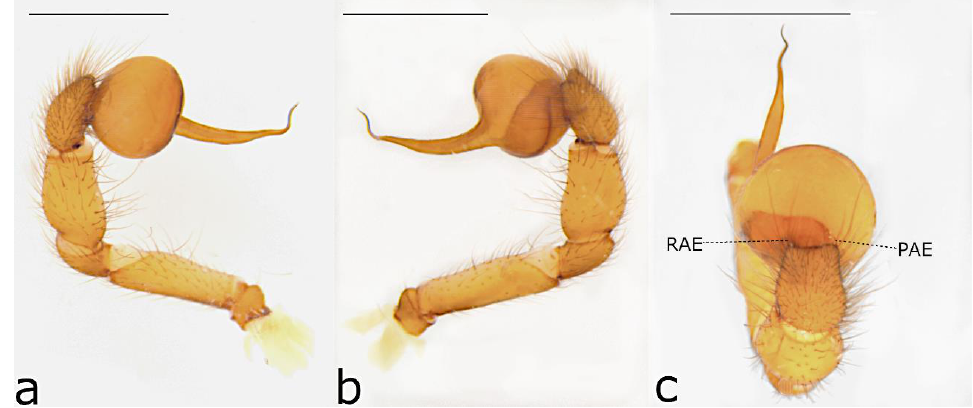
Figure 43. Ariadna insula sp. nov. ♂ holotype (SAMA NN30573) from Franklin Island (SA); ( a ) left pedipalp, prolateral view; ( b ) same, retrolateral view; ( c ) same, cymbium. Scale bar = 1 mm. Legs: Leg length ratio I > II > IV > III. Leg I total 9: femur 2.6, patella 1.1, tibia 2.4, metatarsus 2.3, tarsus 0.6. Leg II 8.2: 2.4, 0.9, 2.2, 2.0, 0.7. Leg III 6.1: 1.8, 0.8, 1.4, 1.3, 0.8. Leg IV 7: 2.2, 0.8, 1.9, 1.3, 0.8 . Legs orange-brown, darker towards apex (Figure 42a – h). Femur I bowed in dorsal view. Metatarsus I without apophyses (Figure 42f – h). Tarsus I